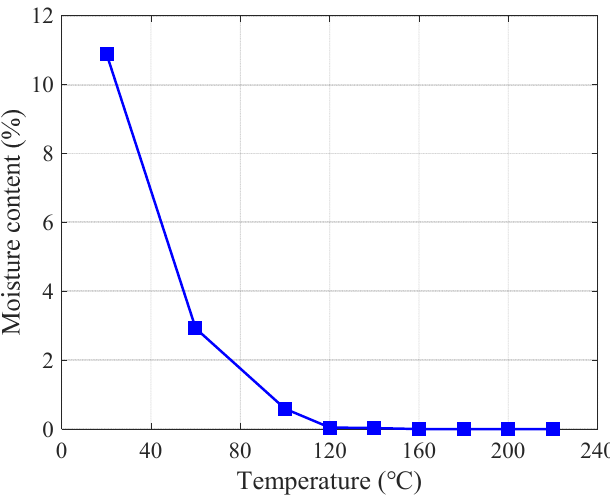
Figure 6. Average moisture content progressions at elevated temperatures.